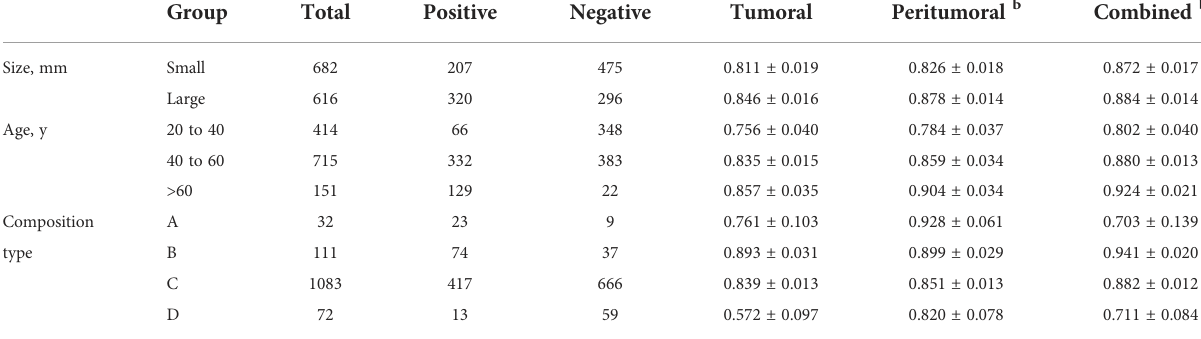
TABLE 6 AUC of three regions (Tumoral, Peritumoral of 2mm, Combined of 2 mm) in subgroups (Size, Age, breast composition types) a . Group Total Positive Negative Tumoral Peritumoral b Combined